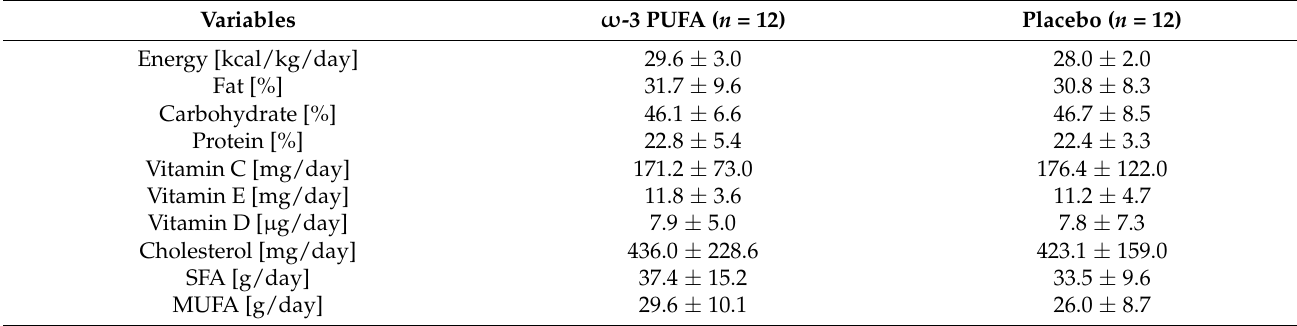
Table 2. Mean daily energy, fat, carbohydrate, protein, vitamins and fatty acids intake in the supplemented ( ω -3 PUFA) and placebo group (Placebo) (mean,